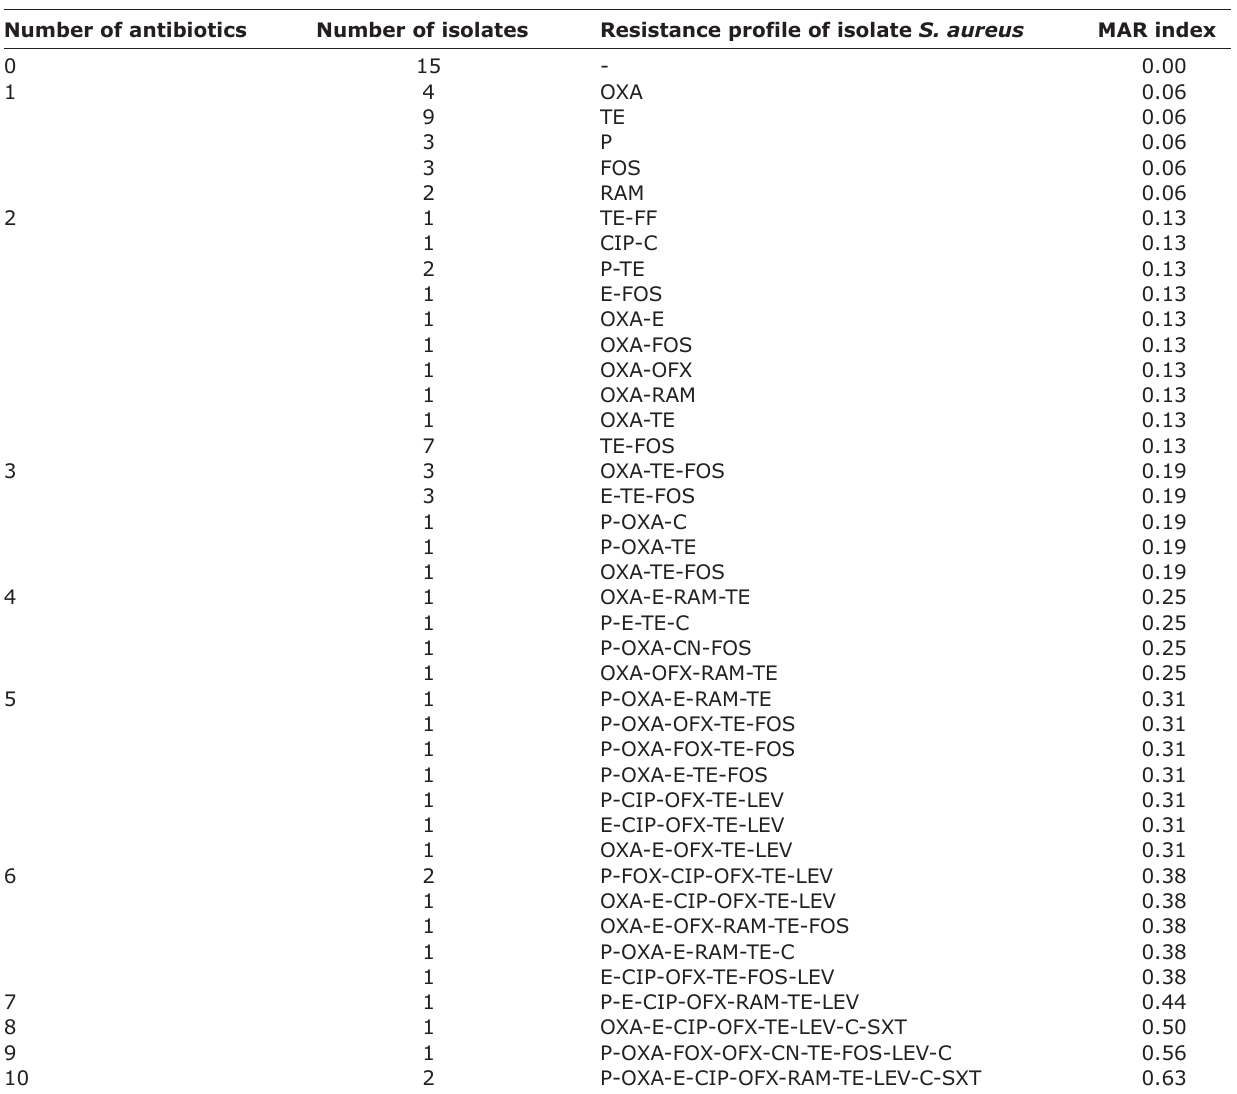
Table-3: Resistance profile of S. aureus isolated. Number of